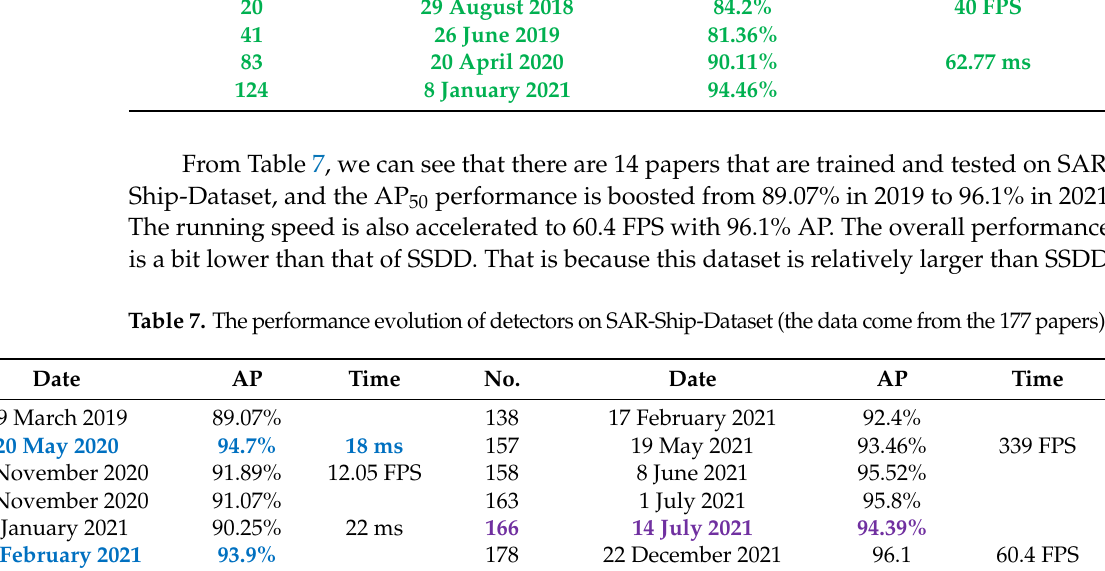
Table 6. The performance evolution of detectors on SSDD+ (the data come from the 177 papers). No.